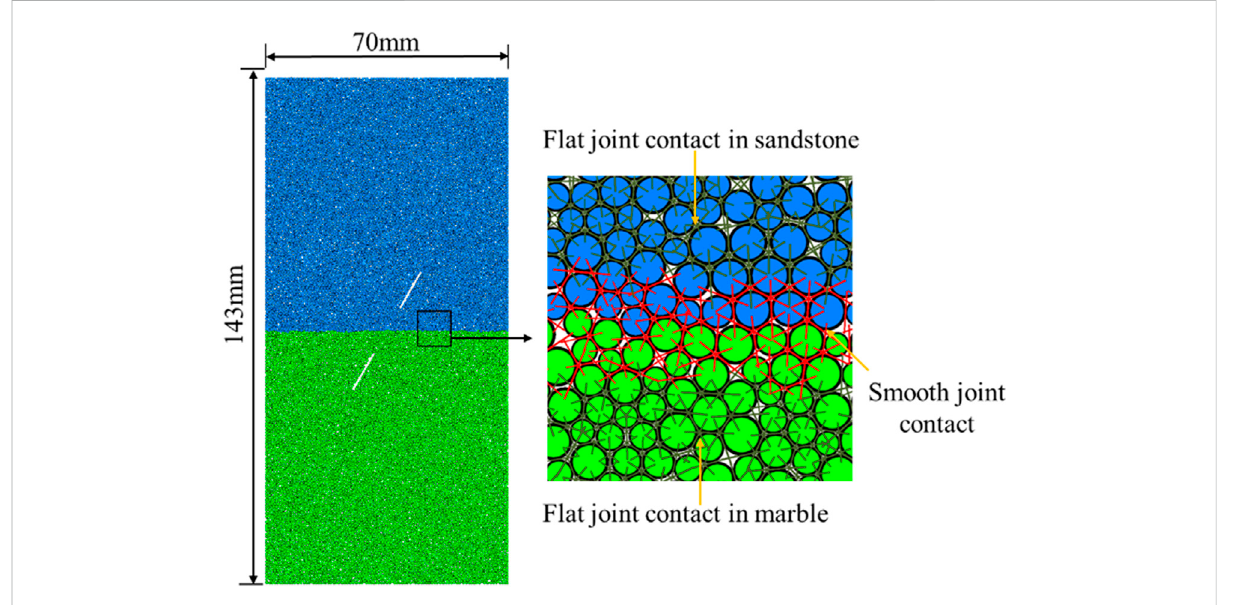
FIGURE 12 Schematic diagram of composite rock model with coplanar double fractures.